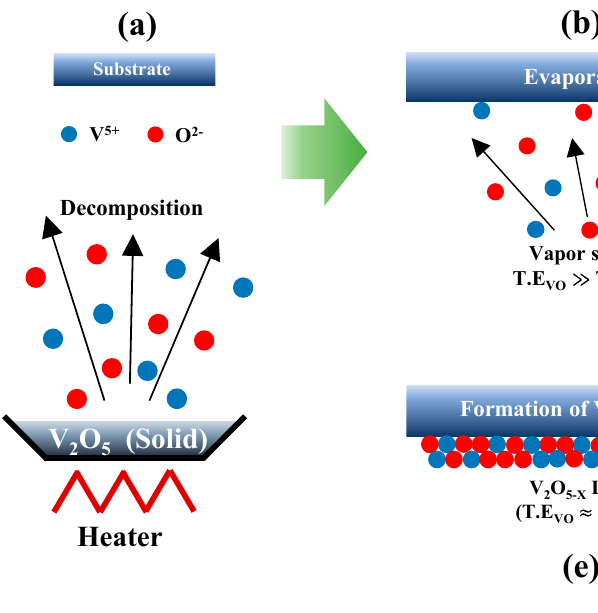
Figure 7. Schematic illustration of the solid-state V 2 O 5 − x TF formation processes. ( a ) crucible heating ( b ) material evaporation ( c ) substrate wetting ( d ) surface transport and nucleation and ( e ) formation of V 2 O 5 − x layer